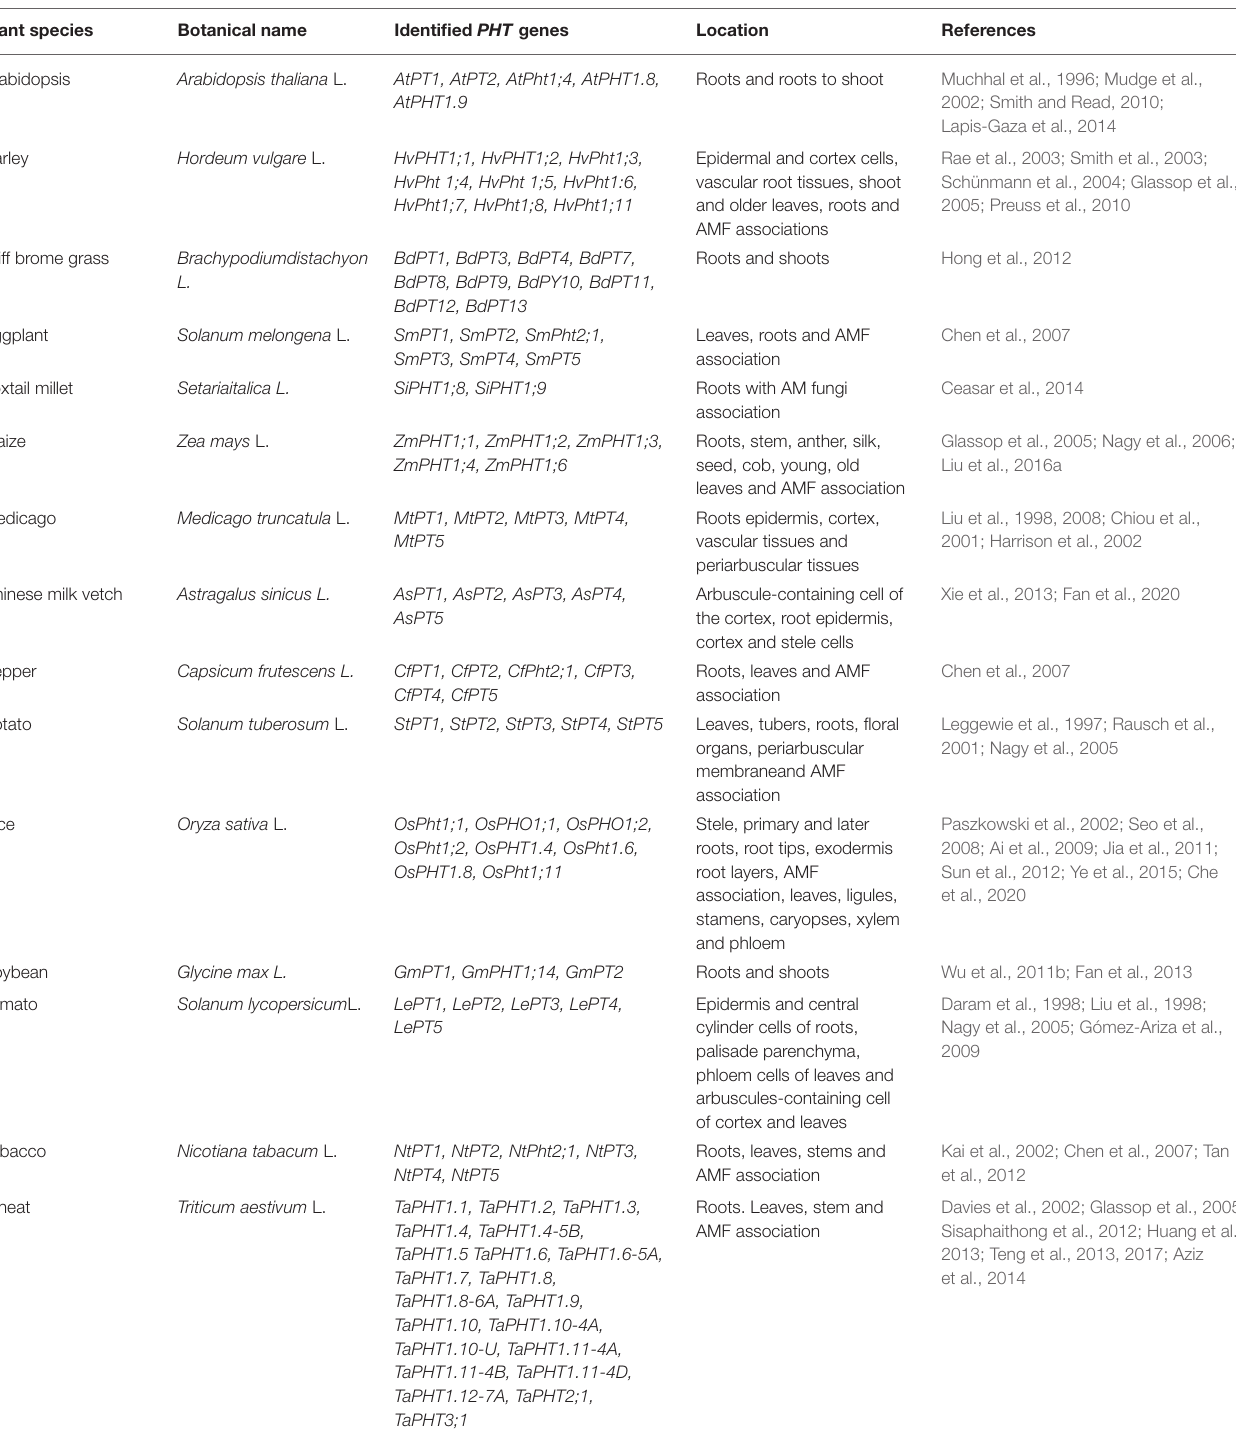
TABLE 2 | Inorganic phosphorus transporter genes in different plant